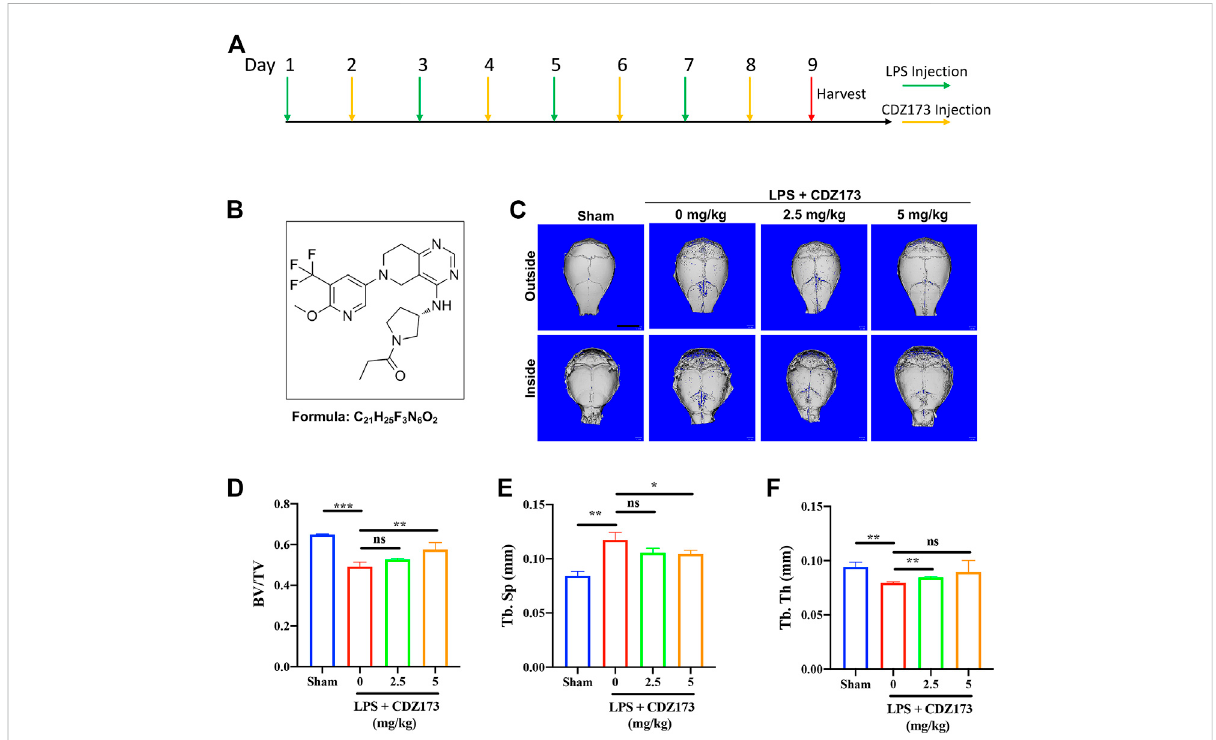
FIGURE 1 CDZ173 protected against titanium LPS-induced osteolysis of the mouse calvaria. (A) The timeline of the animal model. (B) Chemical structure of CDZ173. (C) Three-dimensional reconstructed micro-CT images of calvarial tissue from the Sham, PBS vehicle, and CDZ173 treated groups. (D) Bone volume to tissue volume (BV/TV,%) histomorphometric analysis (E) bone trabecular thickness (F) number of treatment group bone porosity (scale bar = 5 mm) (* p < 0.05, ** p < 0.01, *** p <